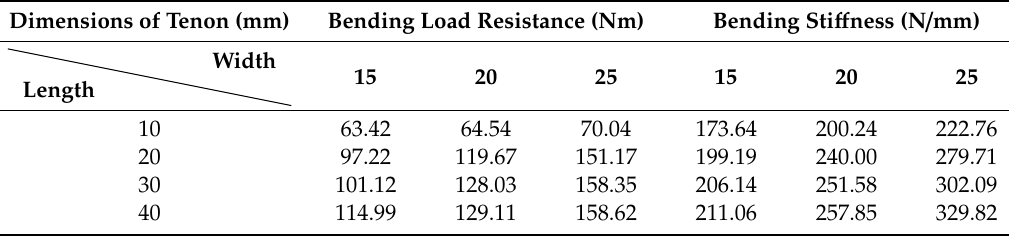
Table 4. Bending moment capacities (BMCs) and stiffness of M–T joint based on FEM. Dimensions of Tenon (mm)